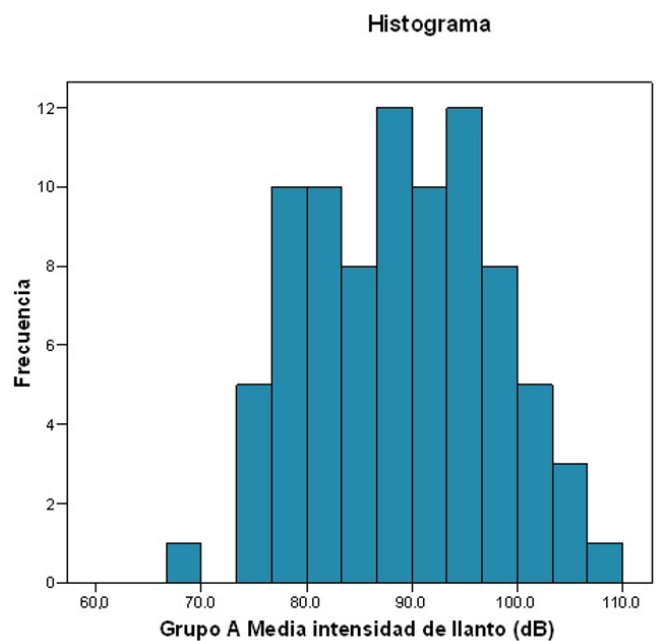
Figure 3. Frequency histogram about crying intensity.